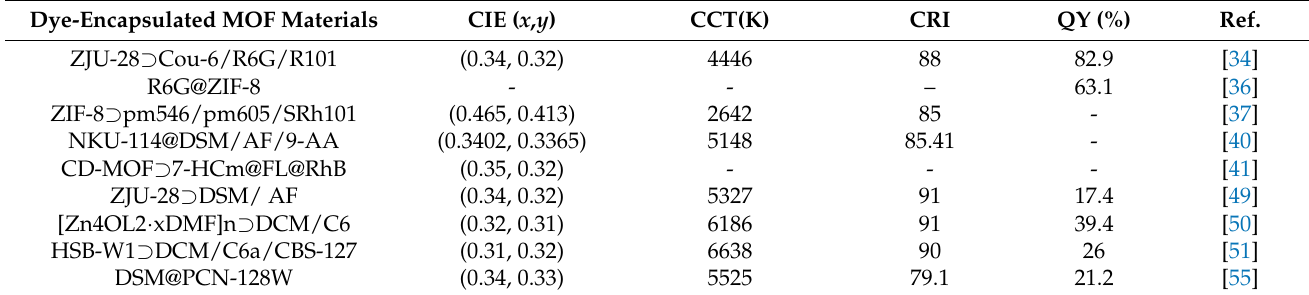
Table 2. Key parameters for white LEDs with dye-encapsulated MOFs as phosphors. Dye-Encapsulated MOF Materials